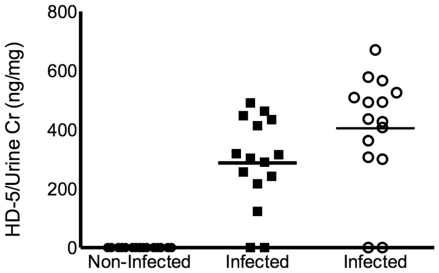
Urinary production of HD5 in infected urine samples.HD5 levels in sterile urine samples and urine samples infected with uropathogenic E.coli. The square boxes depict urinary proHD5 standardized to urine creatinine detected by ELISA assay using monoclonal antibody 8C8. The open circles depict urinary proHD5 and mature HD5 standardized to urine creatinine by immunoblot analysis. ProHD5 and mature HD5 were not detected in sterile urine samples using polyclonal HD5 antisera.